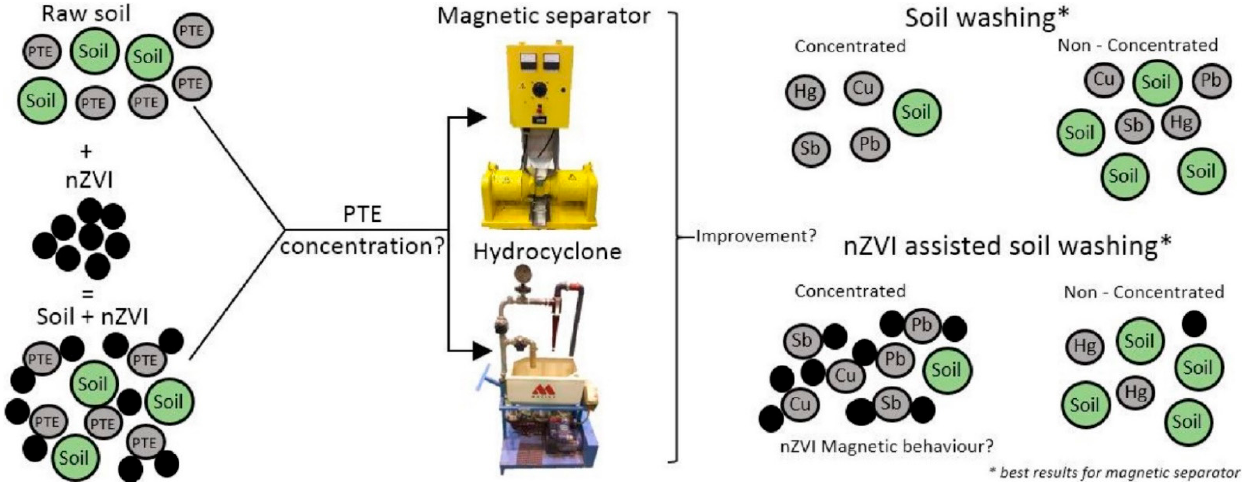
Figure 5. Soil washing assisted nZVI nanoremediation. Reprinted with permission from [115] (2018,